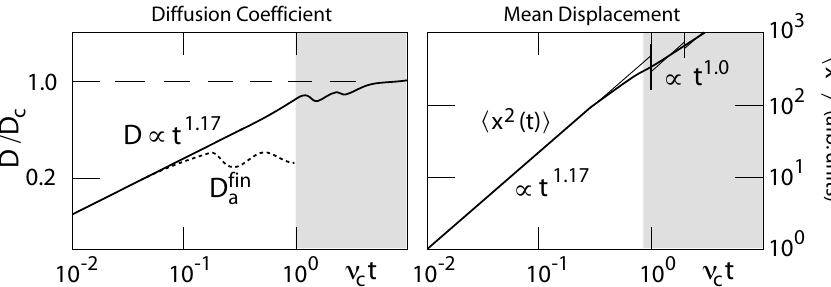
Figure 2. Schematic hypothetical evolution of the diffusion coefficient for the case simulated in Fig. 1 until the collisional classical diffusion state would have been reached. Time is measured here in classical collision times ν − 1 c . (Left) The anomalous increase of the diffusion coefficient with time. The growth of the diffusion coefficient gradually comes to rest after the classical collision time has elapsed. Dotted: A time-dependent nonlinear stationary state never approaching classical diffusion. (Right) Time evolution of the average particle displacement increasing as shown in Fig. 1. When approaching the classical collision time, scattering of particles to both larger and smaller displacements widen the displacement range, leading to a reduced increase until the second collision time. Similarly after the second, third, and the following collision times. Finally, the increase in the displacement settles into linear in time, implying classical or stationary